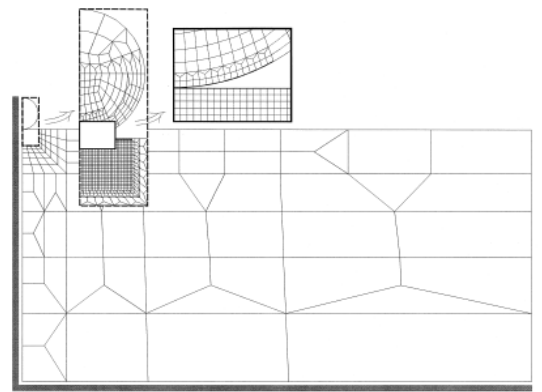
Fig. 2. Discretization of the axisymmetric FE model [23]